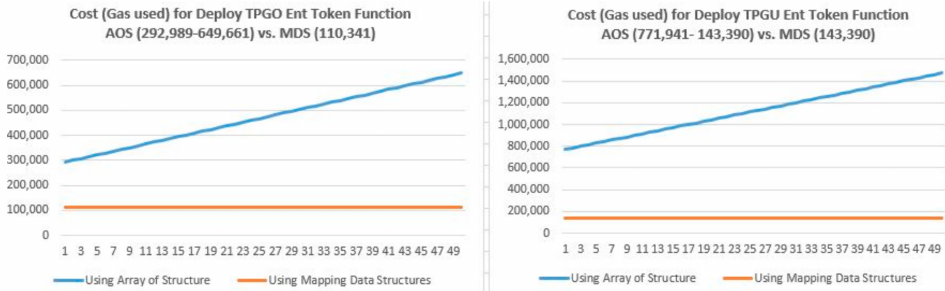
Figure 9. Cost (gas used)—Array of Structure (AOS) vs. Mapping Data Structure